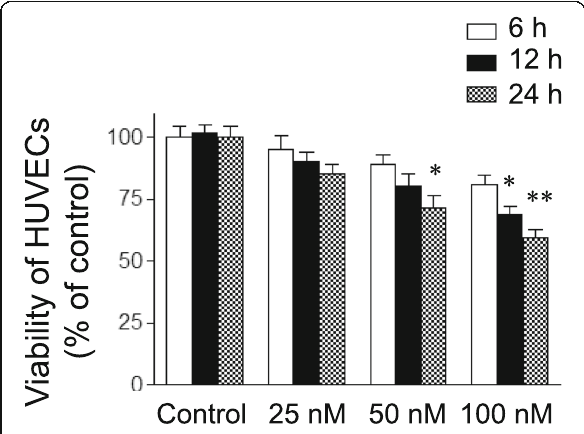
Fig. 1 The effects of triptolide on the viability of human umbilical vein endothelial cells (HUVECs). HUVECs were treated with triptolide (25, 50 or 100 nM) for the indicated times. Cell viability was determined by an MTT assay. Data are expressed as the mean ± standard error of the mean. * p < 0.05 and ** p < 0.01, compared with the corresponding control group